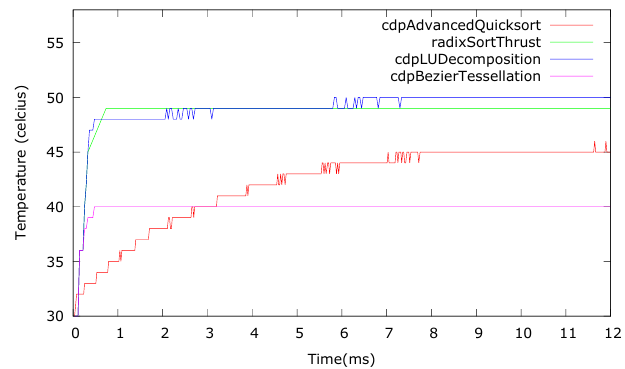
Figure 16. GPU temperature as a function of time.